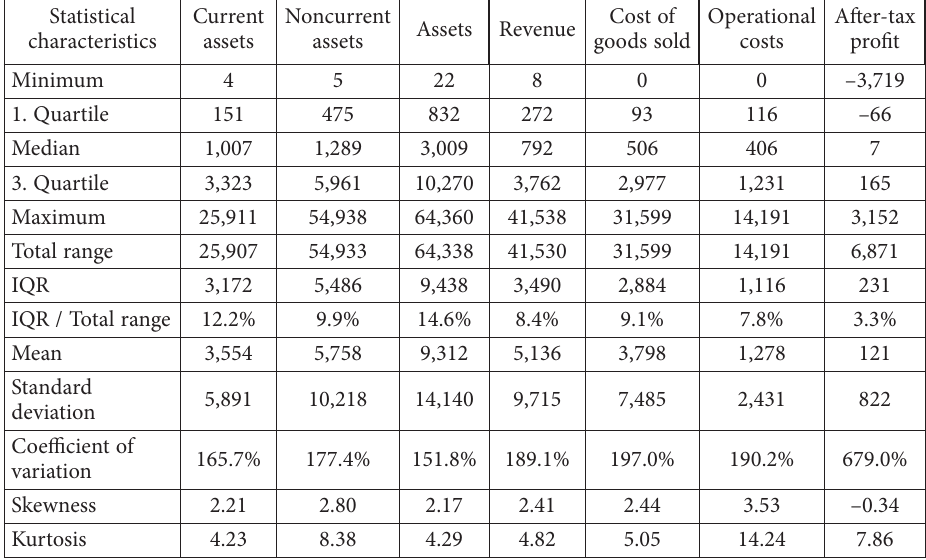
Table 3. Descriptive statistics of SMEs (source: own calculation by R Studio (average of 4 years))(mil- lion tugriks)